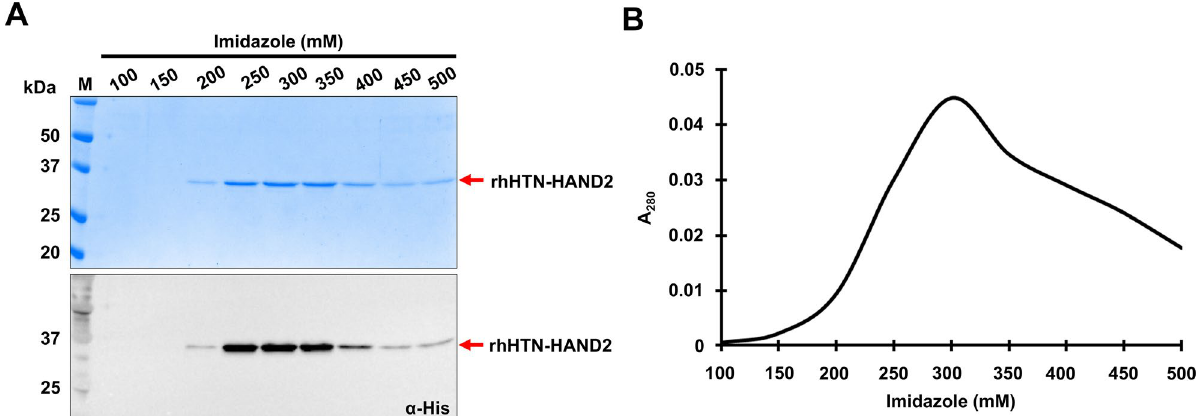
Figure 3. Effect of imidazole concentration on the amount of HAND2 protein eluted. ( A ) The expressed rhHTN-HAND2 protein was purified using affinity chromatography . During purification, the imidazole concentration in the elution buffer was varied to see its effect on the amount of protein eluted. As mentioned in the figure, different concentrations of imidazole were used in the elution buffer, and the protein was eluted. The eluted proteins were analyzed using SDS-PAGE ( top ) and immunoblotting ( bottom ) using an α-his antibody. ( B ) The absorbance of the protein eluted using different concentrations of imidazole in elution buffer was measured at 280 nm, and a graph was plotted with imidazole concentration on the x-axis against absorbance at 280 nm on the y-axis. The uncropped gel and the blot are presented in Supplementary Fig.